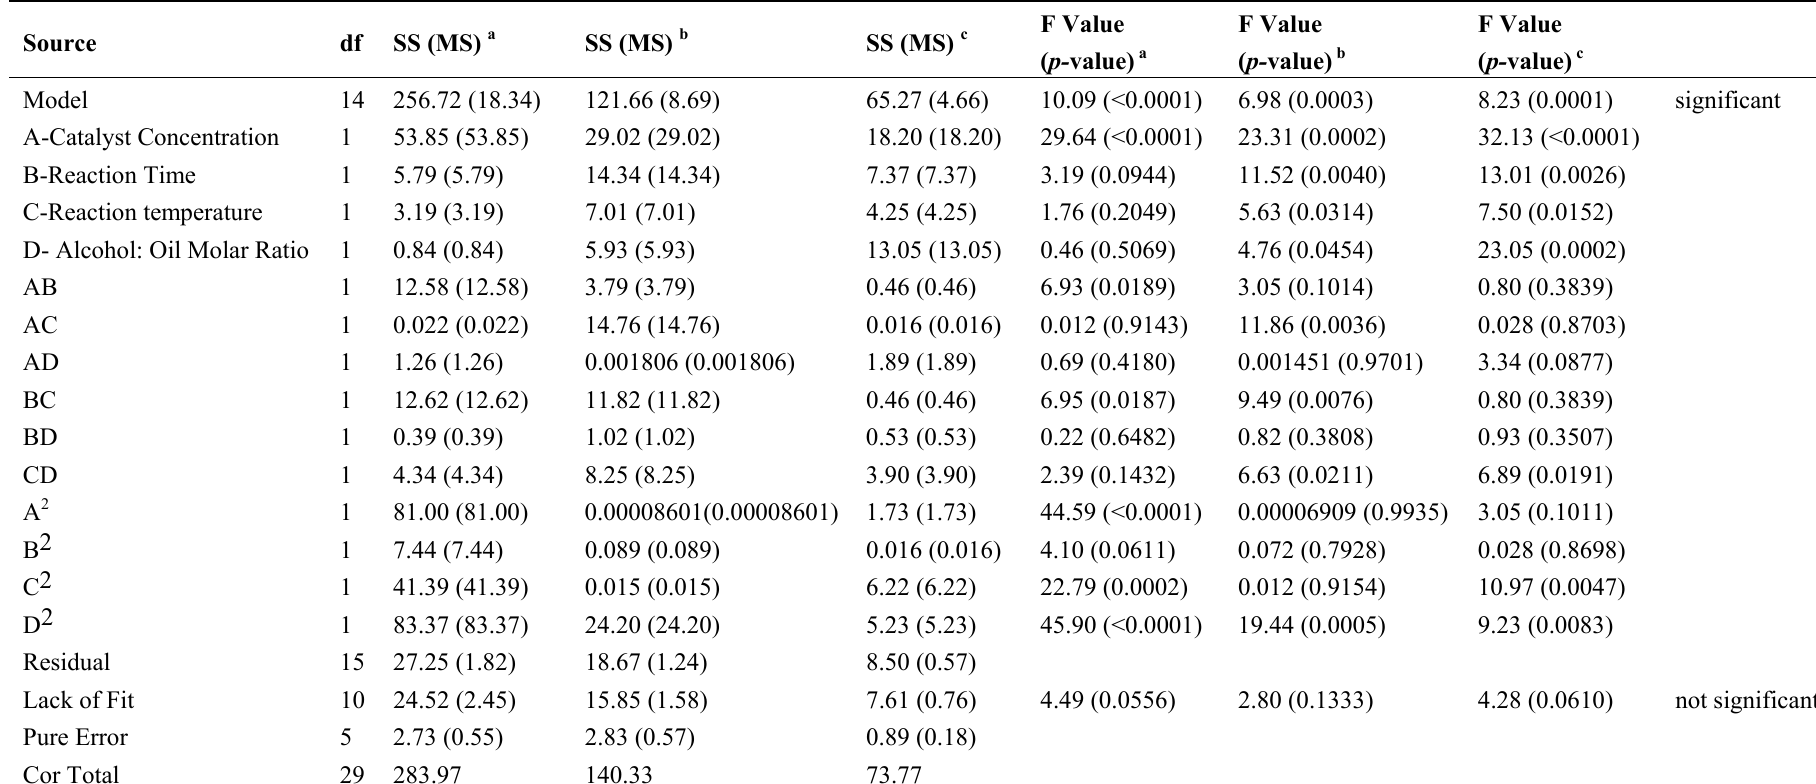
Table 3. Response Surface quadratic model analysis of variance (ANOVA) table for chemical transesterification of rice bran